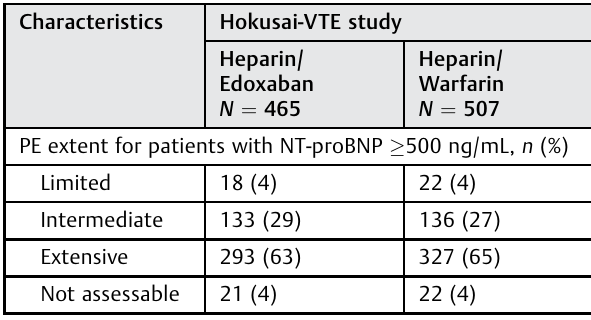
Table 2 Correlation between anatomical extent of PE and elevated NT-proBNP levels Characteristics